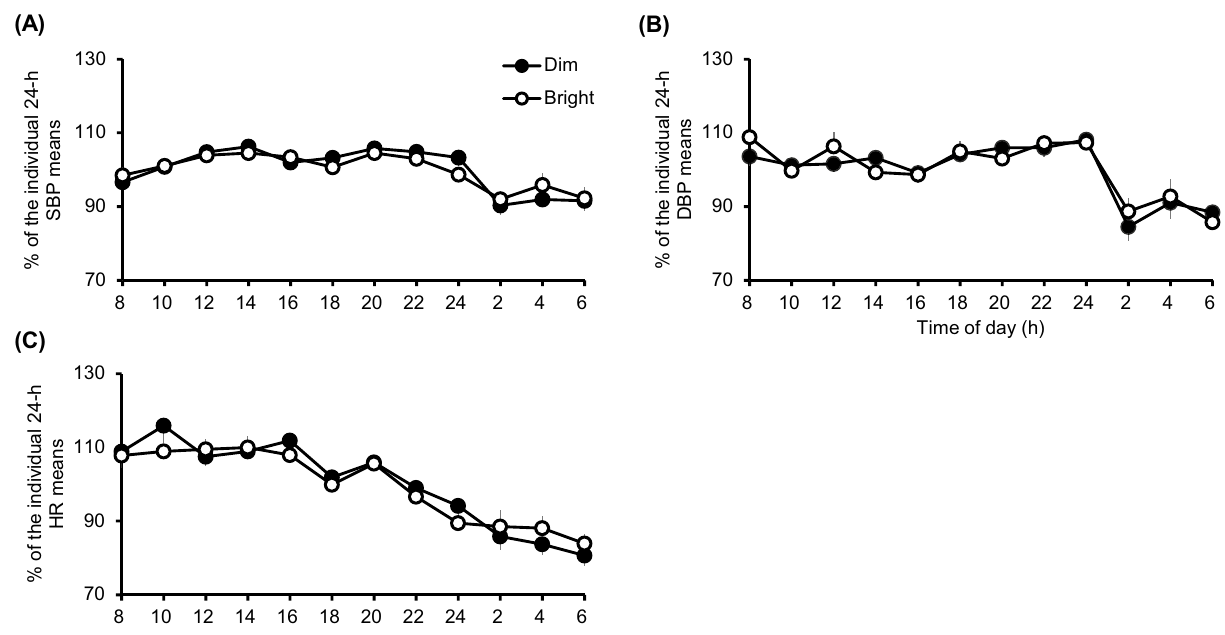
Figure 5. A two-way repeated-measures ANOVA analyses on % of the individual 24-h means in BP and HR. ( A–C ) % of Systolic BP (SBP), diastolic BP (DBP), and HR, respectively, were each very significantly affected by the time of day, but not by light condition. There were no significant time × light condition interactions; means ± SEMs are shown ( N =